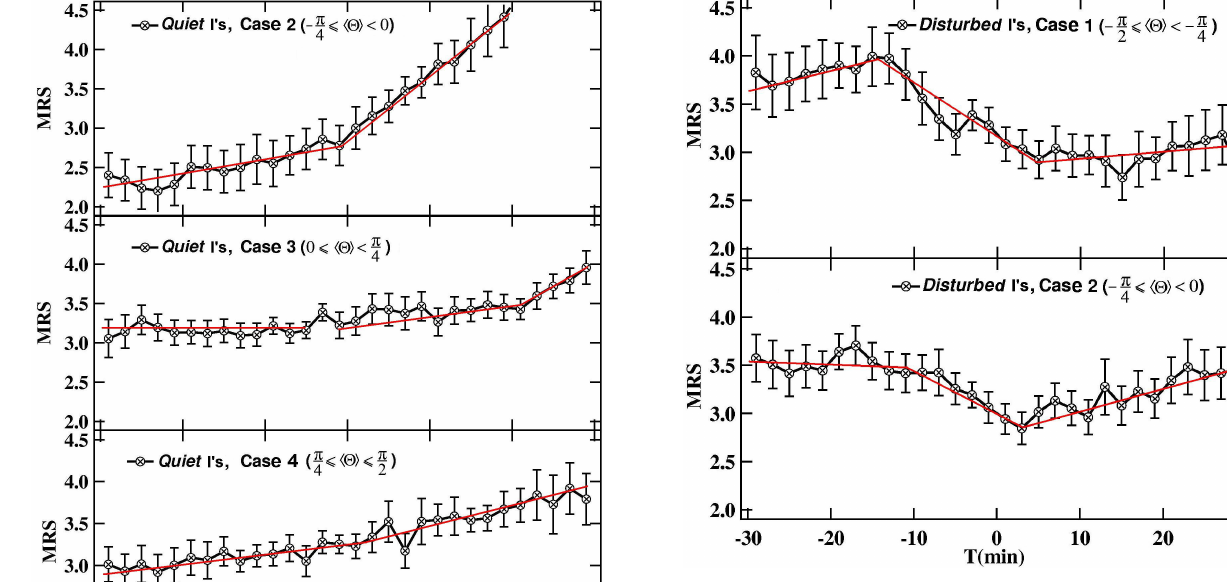
Fig. 8. Disturbed Is classified according to h 2 i . Upper panel: plot of MRS vs. time for Case 1 ( − π/ 2 ≤h 2 i < − π/ 4, 14 events); Lower panel: plot of MRS vs. time for Case 2 ( − π/ 4 ≤h 2 i < 0, 26 events). Table 2. Number of Quiet and Disturbed Is for four subsets de- pending on h 2 i , i.e. the average value of 2 = arctan (B z / | B y | ) , cal- culated over a [− 30 , 10 ] min interval around T WIND